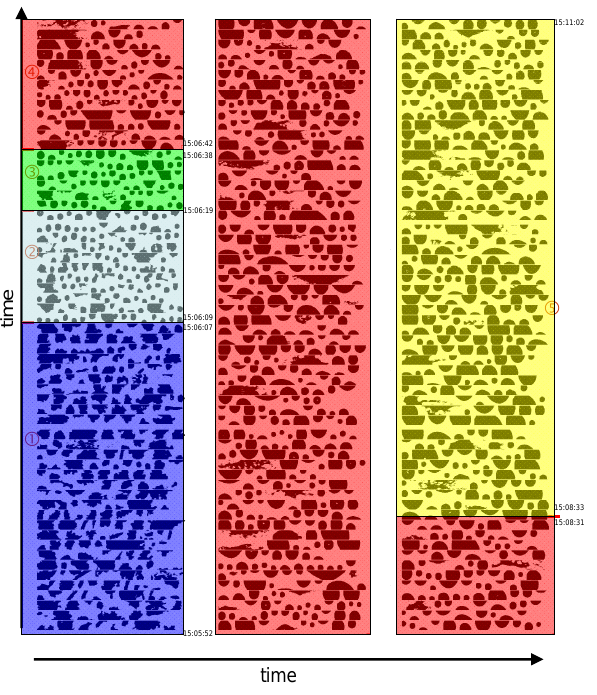
Fig. 11. Two-dimensional images of the melting hydrometeors probed by the in-situ 2DC probe on-board the ATR42 SAFIRE. The five distinct time intervals “1”–“5” are characterized by different precipitating particle types and